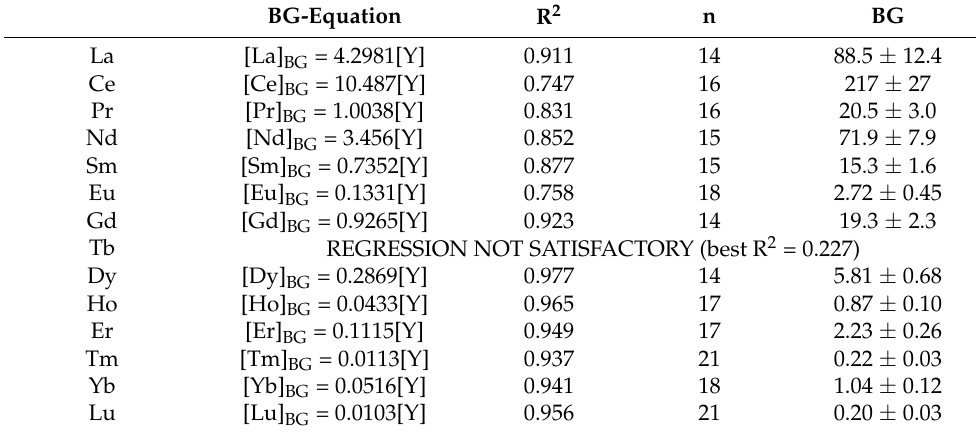
Table 2. Results of the background (BG) equations obtained by least squares iterative simple regres- sion. R 2 is the coefficient of determination, n is the number of samples included in the regression, and BG is the estimated background content from the samples included in the